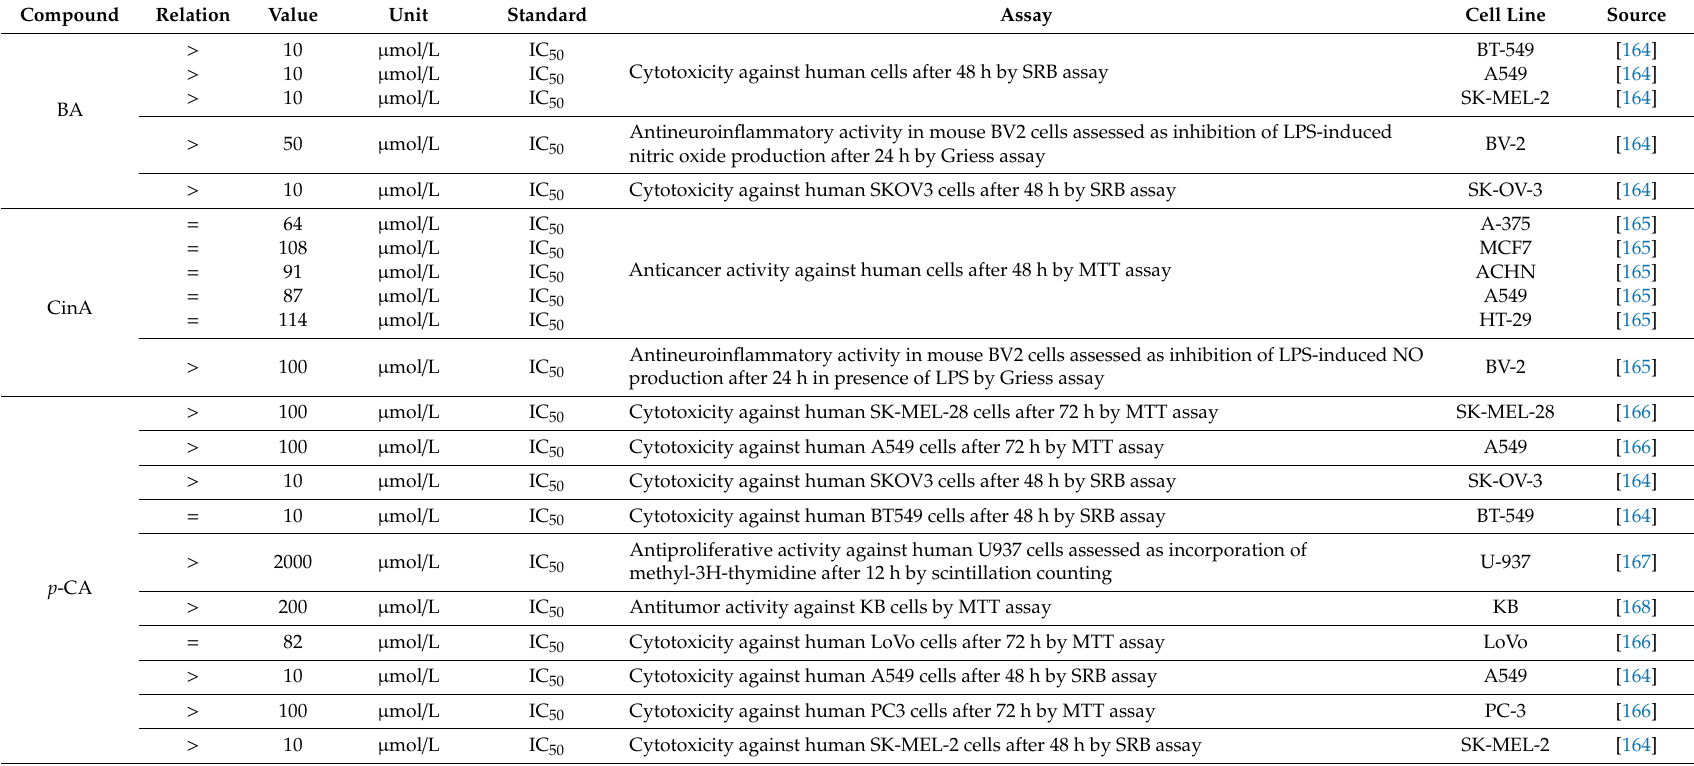
Table 5. E ff ects of NCA on selected cell lines in in vitro